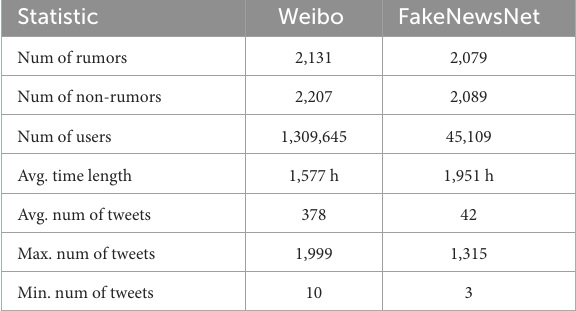
TABLE 1 The statistics of two benchmark rumor detection